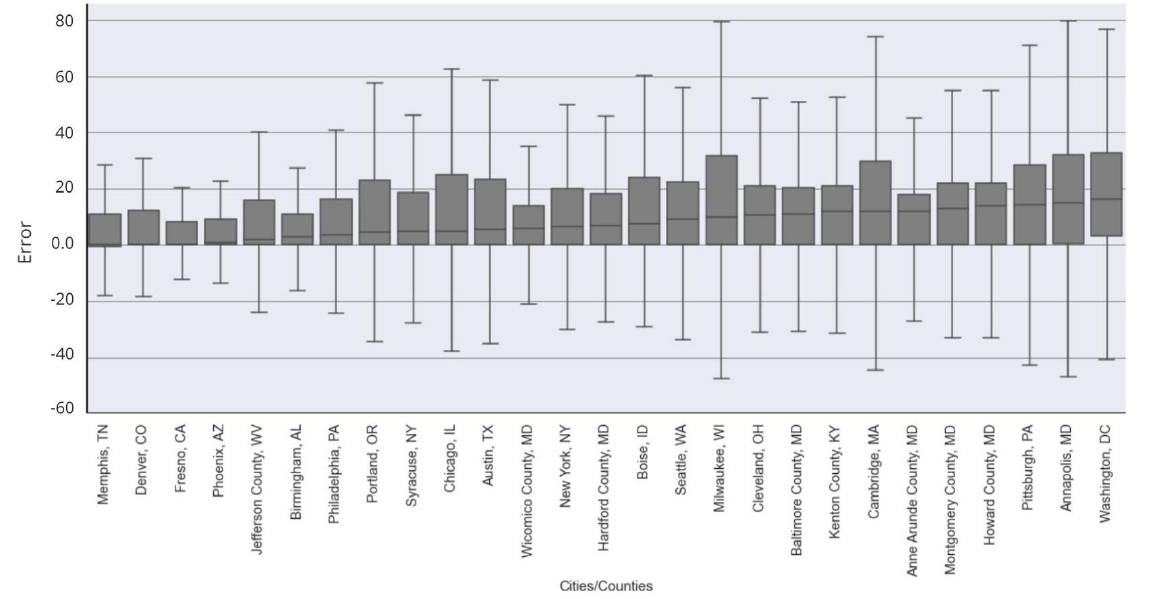
Figure 7. National Land Cover Database-Tree Canopy error (deviation by % when compared to high-resolution derived data) by cities/counties.